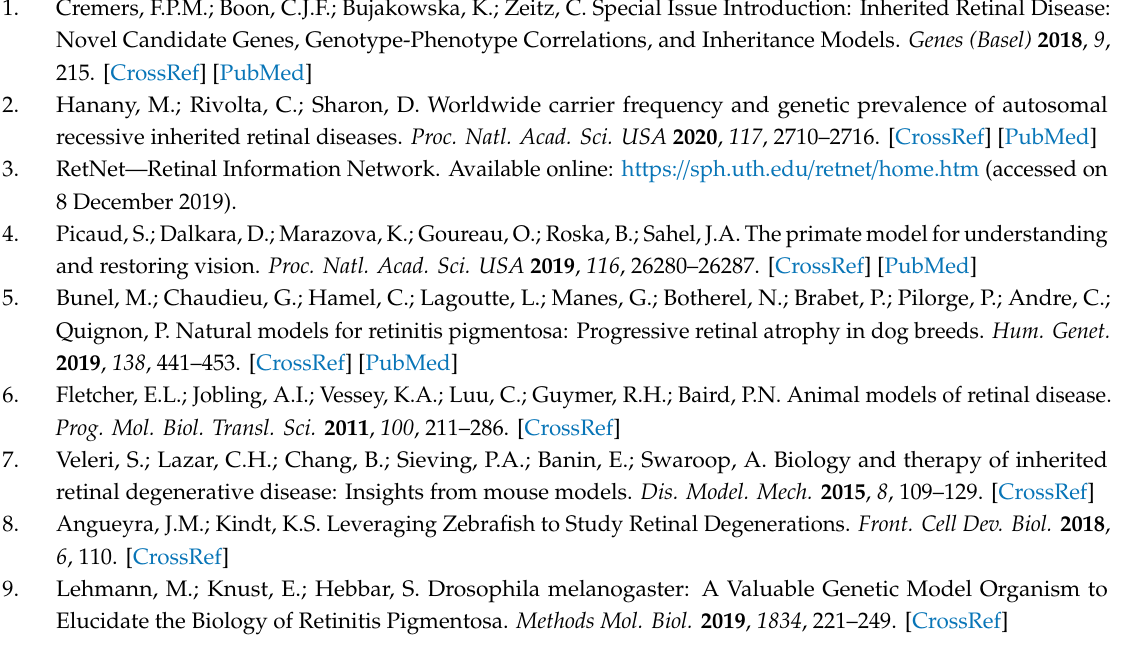
Figure S1: OCT and fundus images of C57BL / 6J control mice at various ages, Table S1: Monogenic mouse RD models with PR cell loss, Table S2: Description of gene / protein symbols used in the text and